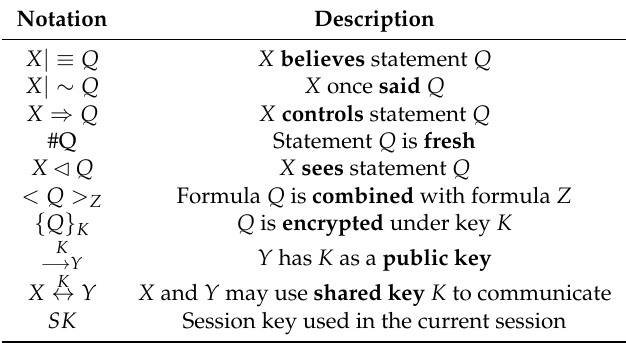
Table 2. Notations of Burrows–Abadi–Needham (BAN)